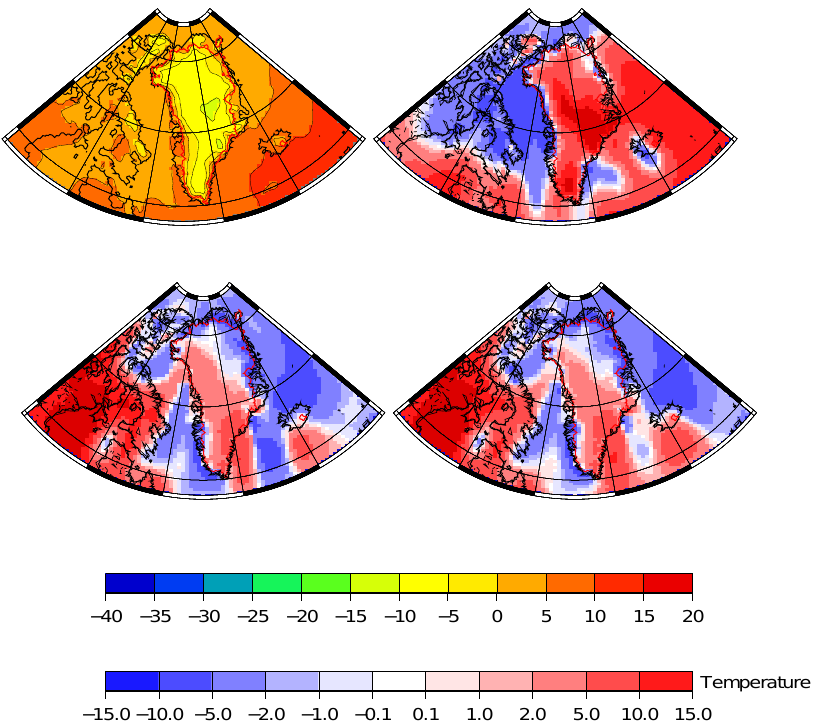
Figure 15. Difference in July temperature between the climatology and the different experiments: CTRL (b) , SNOW (c) , PRECIP (d) . The reference climatology is shown in (a)